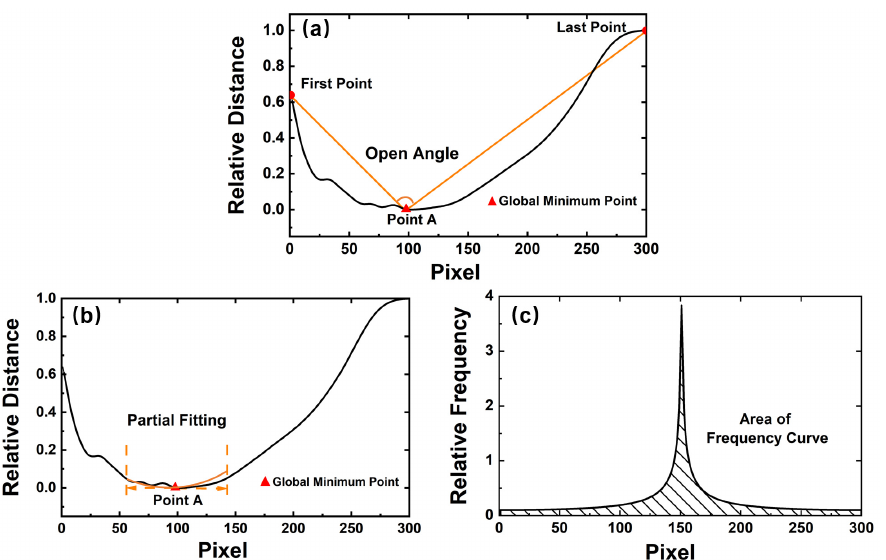
Figure 7. Three features of surgical masks: ( a ) opening angle of the contour curve, ( b ) quadratic coefficient of the partial fitting curve, and ( c ) area of the frequency curve from the Fourier transform of the spatial contour curve.